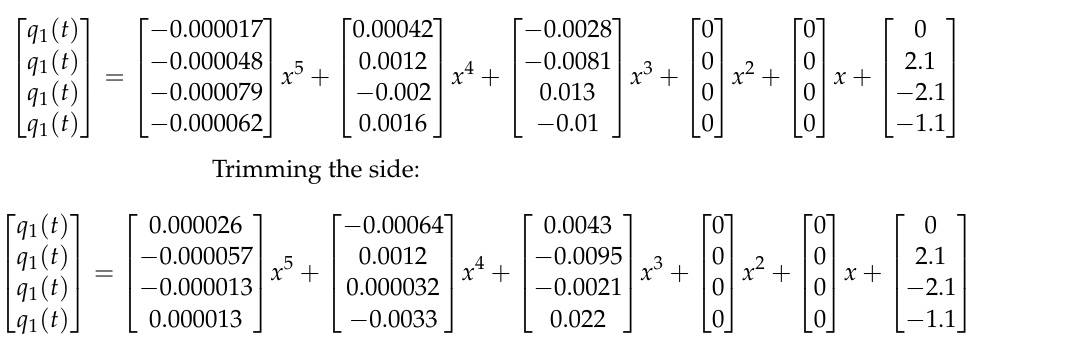
p 2 Figure 6. Valve-controlled hydraulic cylinder model . The linearized flow equation of the valve is: 𝑄 (cid:3013) = 𝑘 (cid:3044) 𝑥 (cid:3049) − 𝑘 (cid:3030) 𝑃 (cid:3013)